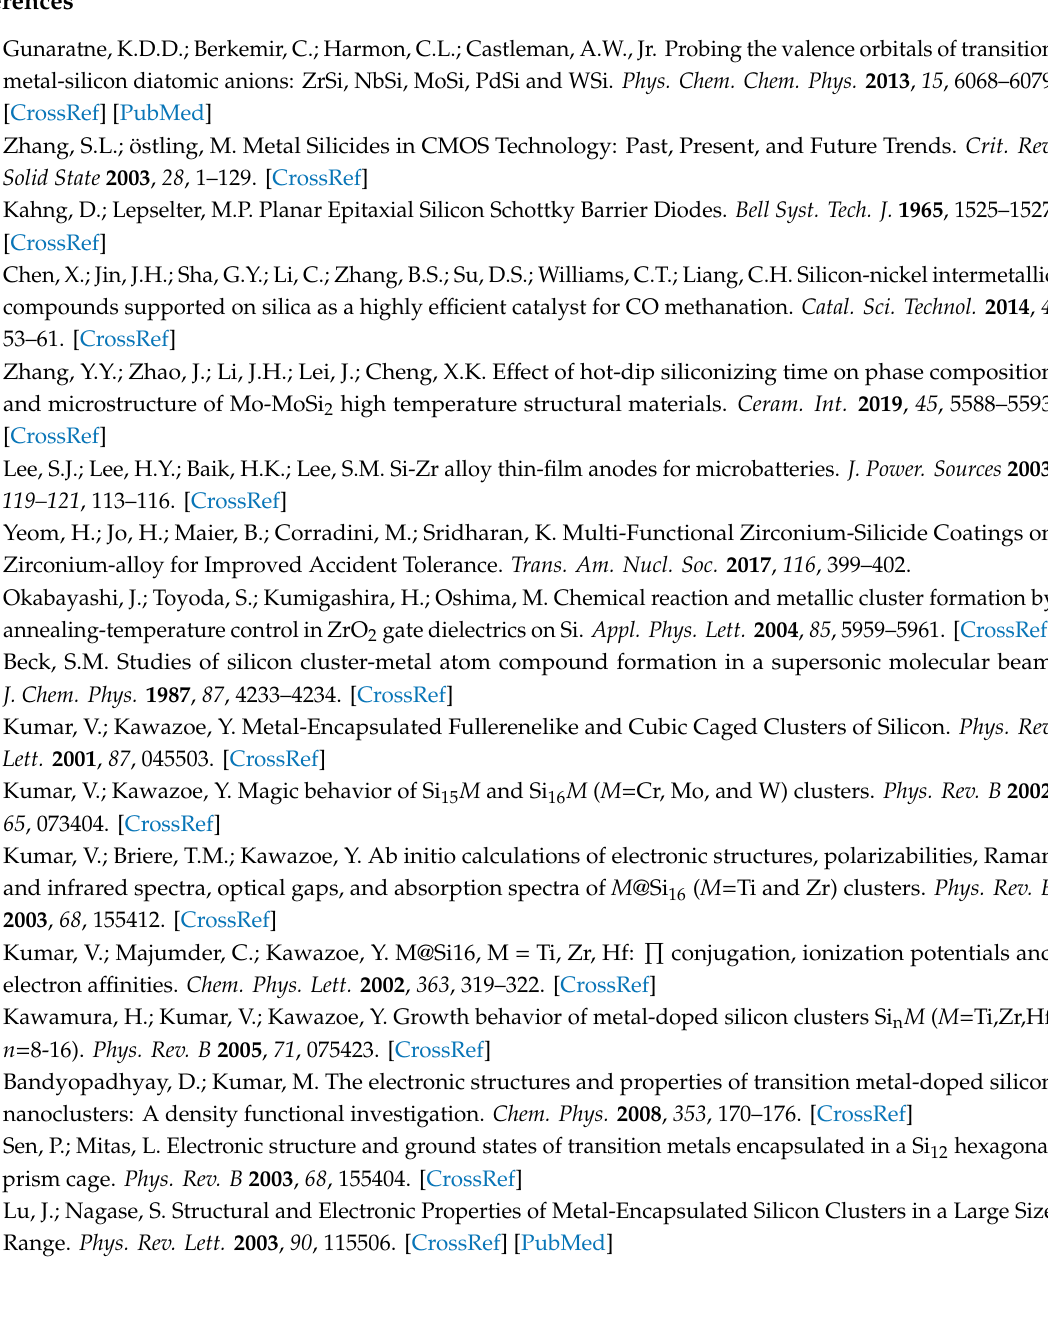
2933 / s1. Figure S1. Low-lying isomers of neutral ZrSi n ( n = 6–16) clusters, point group and relative energy (in eV). Figure S2. Low-lying isomers of mono-anionic ZrSi n - ( n = 6–16) clusters, point group and relative energy (in eV). Figure S3. Low-lying isomers of di-anionic ZrSi n 2- ( n = 6–16) clusters, point group and relative energy (in eV). Figure S4. The HOMO-LUMO energy gap ( E gap ) of ZrSi n 0 / - / 2- ( n = 6–16) clusters. (m) stands for mPW2PLYP calculations and (p) stands for PBEPBE calculations. Table S1. Conformational population (%) for low-lying geometries of ZrSi n 0 / - / 2 species ( n = 6–16)